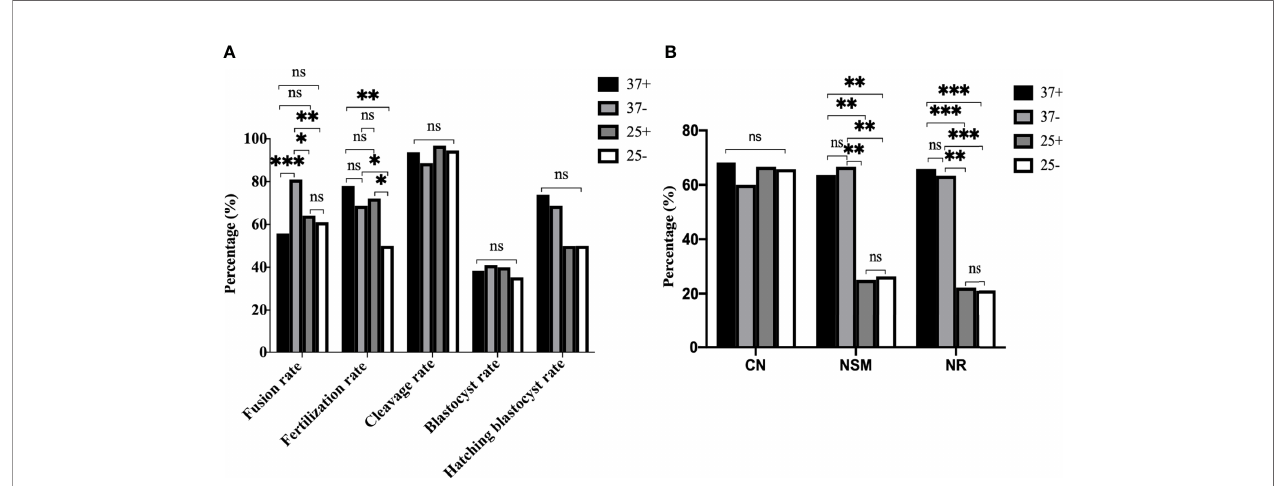
FIGURE 8 | The optimum operating condition for electrofusion ST technology was the 37°C group without Ca 2+ . (A) Culture results showed that the fusion rate was the highest in 37-, the fertilization rate in 25- was the lowest, with no difference in the fertilization rate existing between 37+, 37-, and 25+. *P<0.05, **P<0.01, ***P <0.001, and ns P>0.05. (B) 25°C treatment after enucleation had adverse effects on the spindle morphology and g -tubulin localization in mice oocytes reconstructed via ST. NSM and NR in 37+ and 37- were both signi fi cantly higher than those in 25+ and 25-, with no difference existing between 37+ and 37-. **P<0.01, ***P <0.001, and ns P>0.05. 37+, 37-, 25+, and 25- respectively represent the 37°C group containing Ca 2+ , the 37°C group without Ca 2+ , the 25°C group containing Ca 2+ , and the 25°C group without Ca 2+ . Data is expressed as a percentage